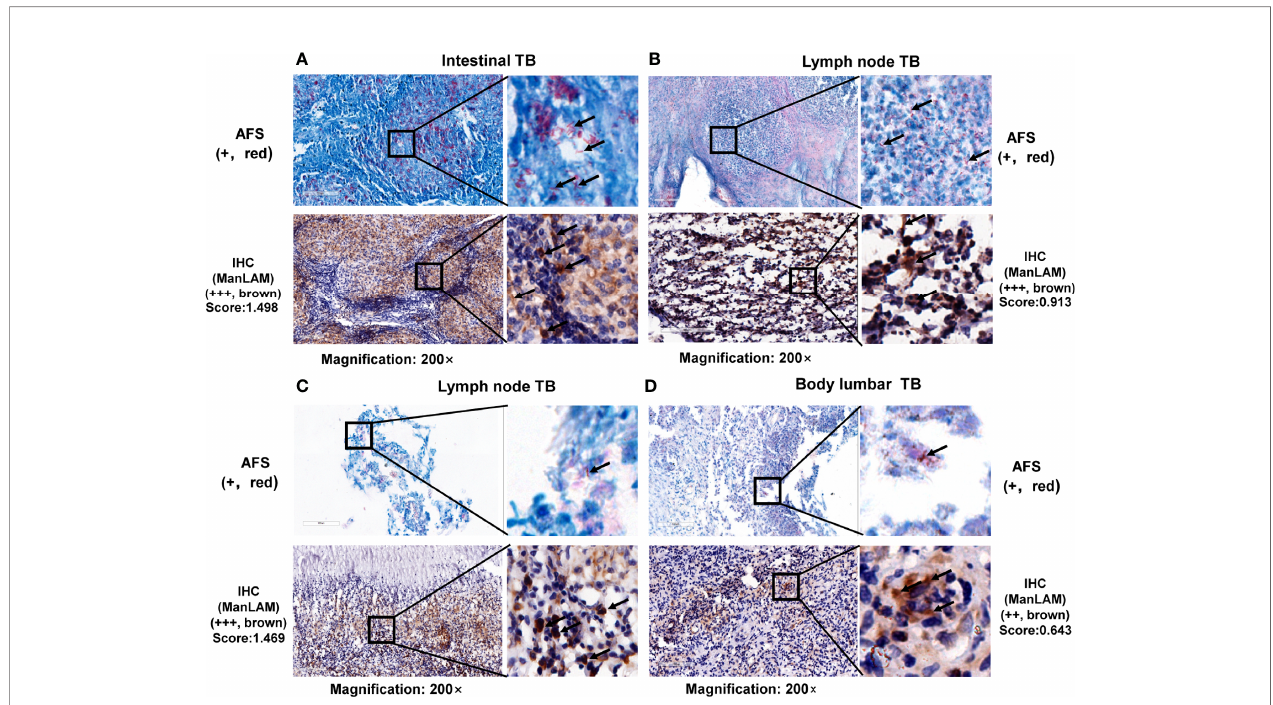
FIGURE 2 | Representative images and comparison between acid-fast staining and ManLAM-based immunohistochemistry (IHC) on lesion tissues. Representative images of (A) lesion sections of intestinal tuberculosis (TB) patient, (B, C) tissues of lymph node TB patients, and (D) lesion sections of body lumbar TB. TB, tuberculosis. Black arrows indicate positive signals (AFS by red staining, or aptamer-based IHC by brown granular staining). Samples with a score less than the cutoff value (0.0580) were designated as “ - ” , ( ≥ 0.0580 and <0.5010) as “ + ” , ( ≥ 0.5010 and <0.8780) as “ ++ ” , >0.8780 as “ +++ ” . The numbers (0.5010 and 0.8780) were determined by calculating the 50% and 75% percentile of the